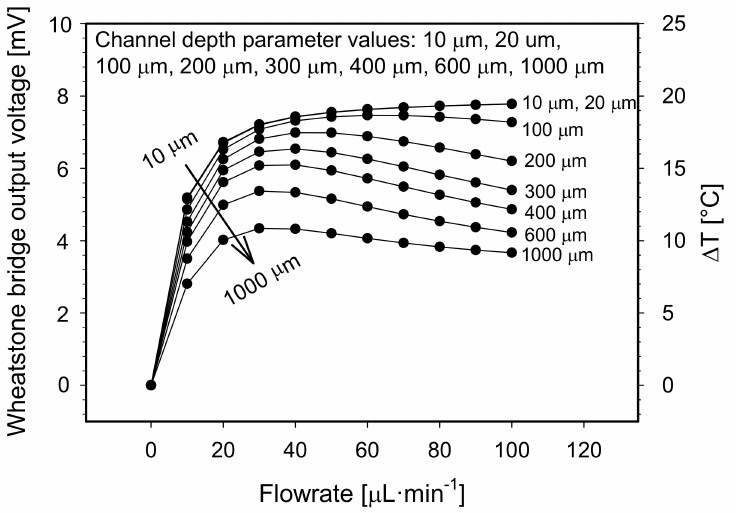
Figure 8. Constant temperature S-H-S flowmeter configuration: simulated Wheatstone bridge output voltage and differential temperature between both sensor elements vs. flowrates for preselected channel depth parameter